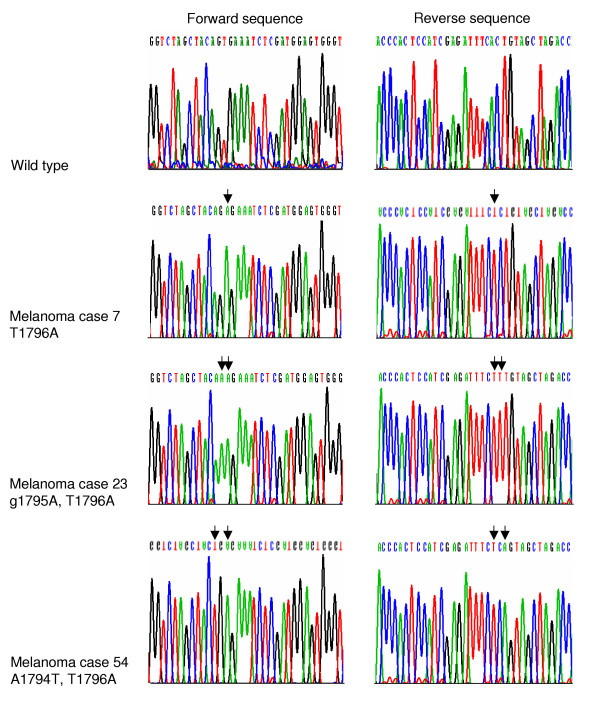
Part of the DNA sequence of the activation segment of the B-raf kinase domain. Representative melanoma resection specimens are shown which harbour missense mutations. In comparison to wild type DNA sequence (upper electropherogram, forward sequence on the left, reverse sequence on the right), melanoma cases 7, 23 and 54 exhibit nucleotide transitions, among them the activating T1796A mutation.